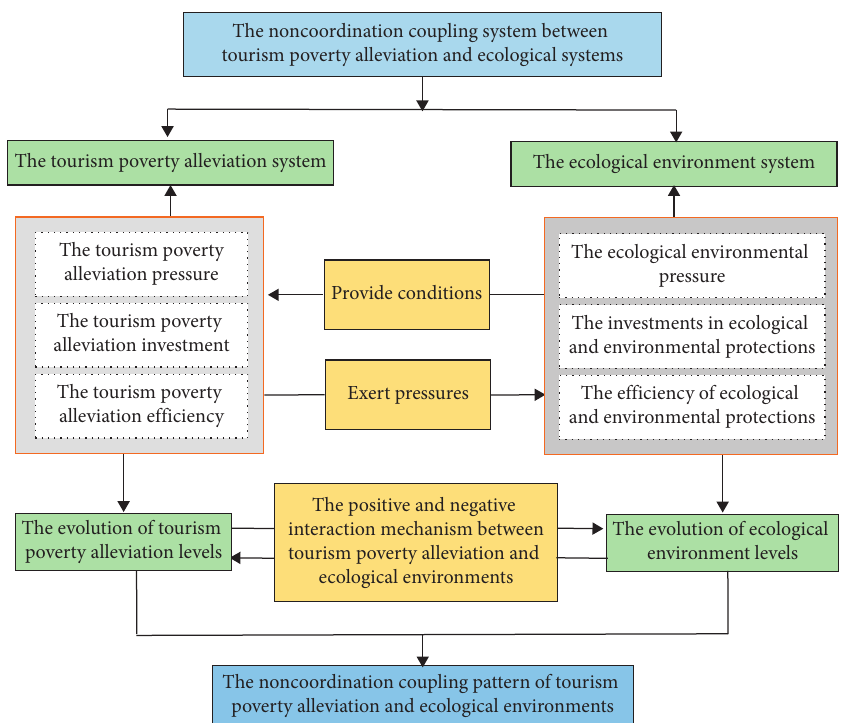
Figure 2: The coupling noncoordination drive mechanism assessment model framework of the tourism poverty alleviation and ecological